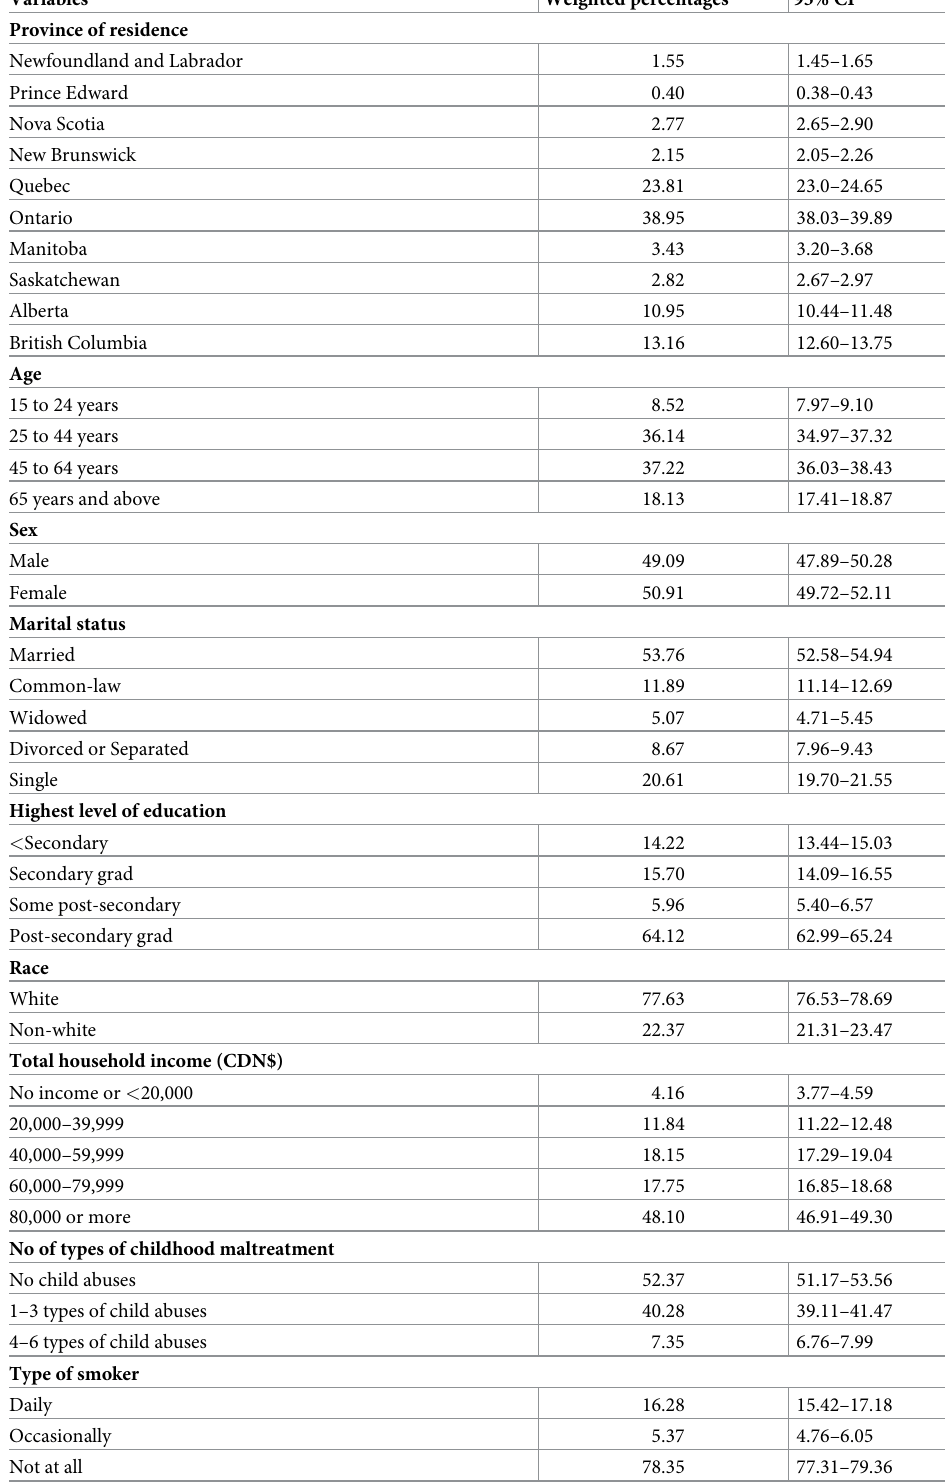
Table 1. CCHS 2012: MH participants socio-demographic characteristics and distribution of DSM-IV